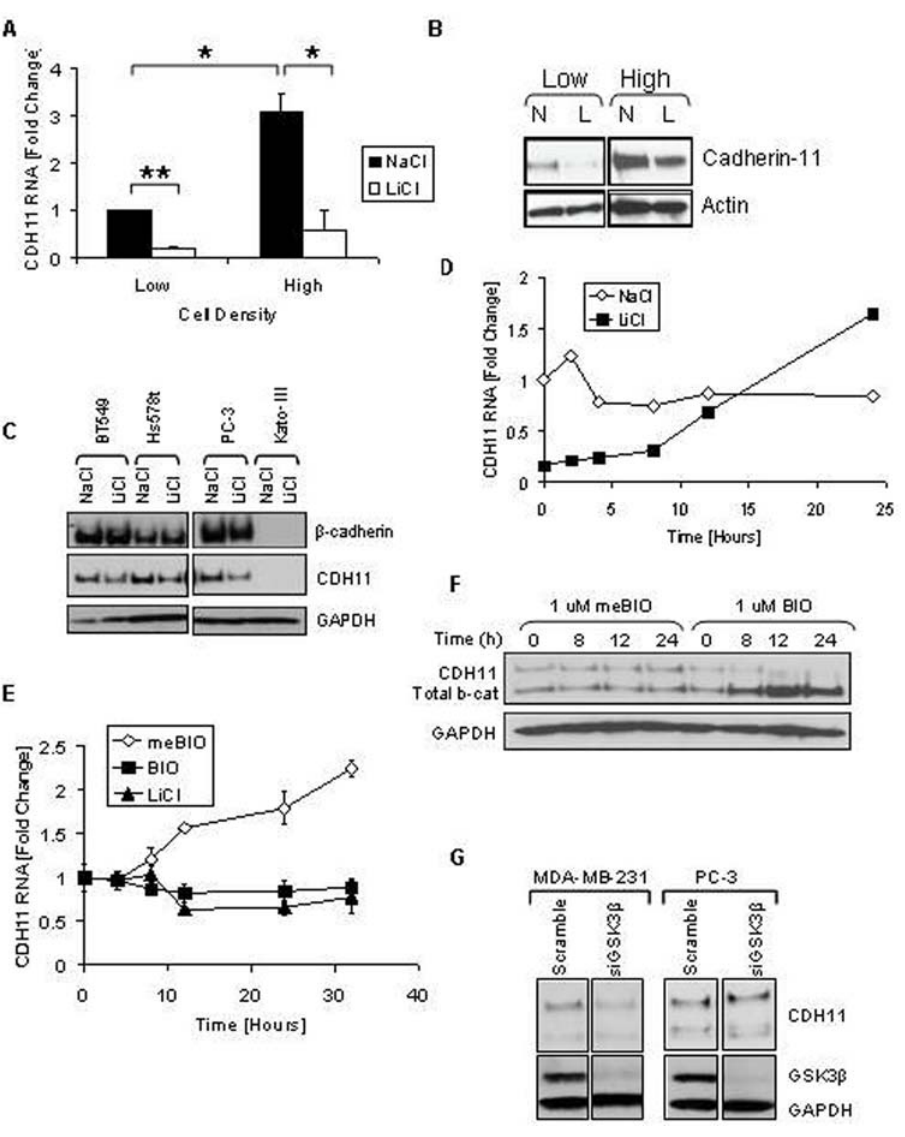
Figure 1. Density increases cadherin-11 and GSK3 b inhibitors decrease cadherin-11 expression. A and B: MDA-MB-231 cells were plated at two densities, 50% and 90% confluency, called low and high, respectively. The cells were allowed to grow overnight in serum-free medium. 24 hours after plating cells were treated with 20 mM NaCl (N) or 20 mM LiCl (L). 24 hours after treatment, RNA and protein were collected for real- time PCR (A) and Western (B) analysis. C: Cancer cells BT549, Hs578T, PC-3, and Kato-III were plated at a medium density and allowed to adhere. Cells were then treated with 20 mM LiCl or NaCl control. 48 hours after transfection protein was collected for Western blot analysis. D: MDA-MB-231 cells were plated at a medium density, serum starved overnight, and treated with 20 mM NaCl or 20 mM LiCl. 24 hours after treatment, the cells were washed once with PBS and maintained in serum-free medium containing only 20 mM NaCl. RNA was collected at the times indicated for real-time PCR analysis. E and F: MDA-MB-231 cells were plated at a medium density and serum starved overnight. 16 hours after plating, the cells were treated with 1 m M meBIO (control), 1 m M BIO, or 20 mM LiCl. RNA (E) or protein (F) was collected at the designated times and analyzed using real-time PCR (E) and Western blot analysis (F). G: MDA-MB-231 and PC-3 cells were transfected with either non-specific scrambled siRNA (siScramble), or siRNA directed against GSK3 b (si GSK3). 48 hours after transfection protein was isolated for Western blot analysis.